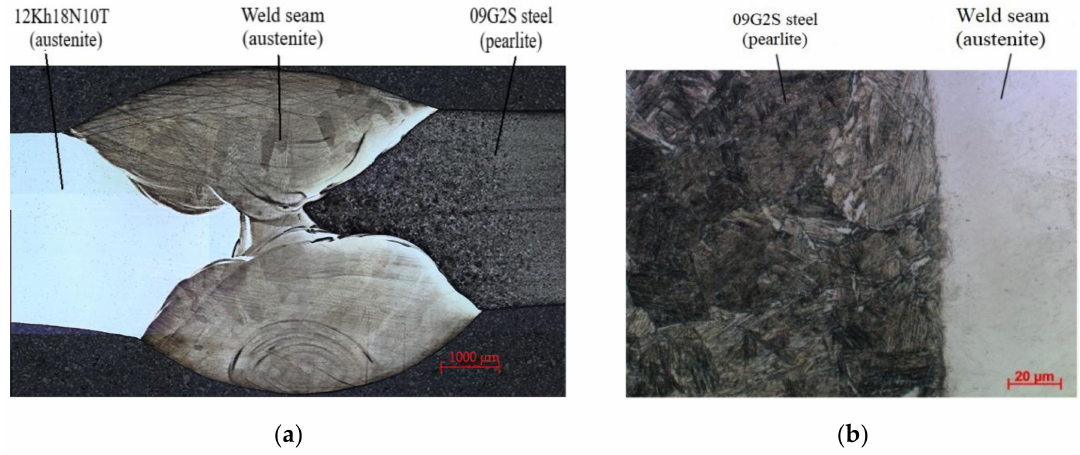
Figure 1. Welded joint of steel 09G2S and 12Kh18N10T ( a ) and fusion line from the side of the steel 09G2S ( b